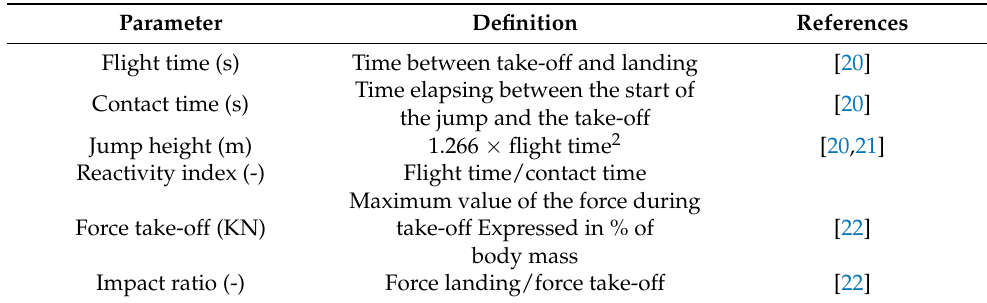
Table 2. Jump variables from Baiobit user